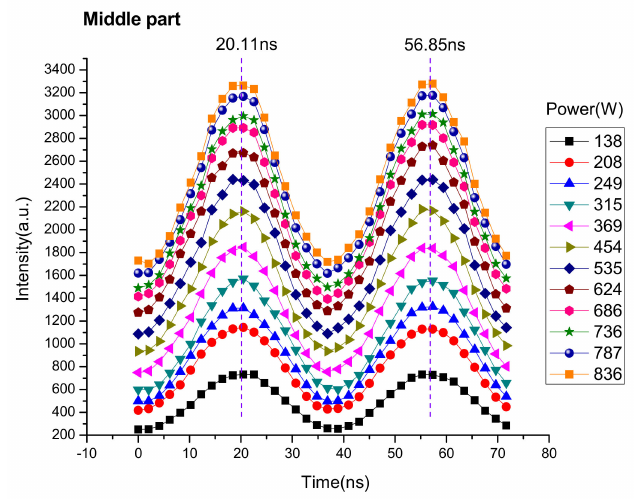
Figure 6. The curves of luminescence intensity of middle part in 4.4 mm argon DBD in one current cycle at different power.